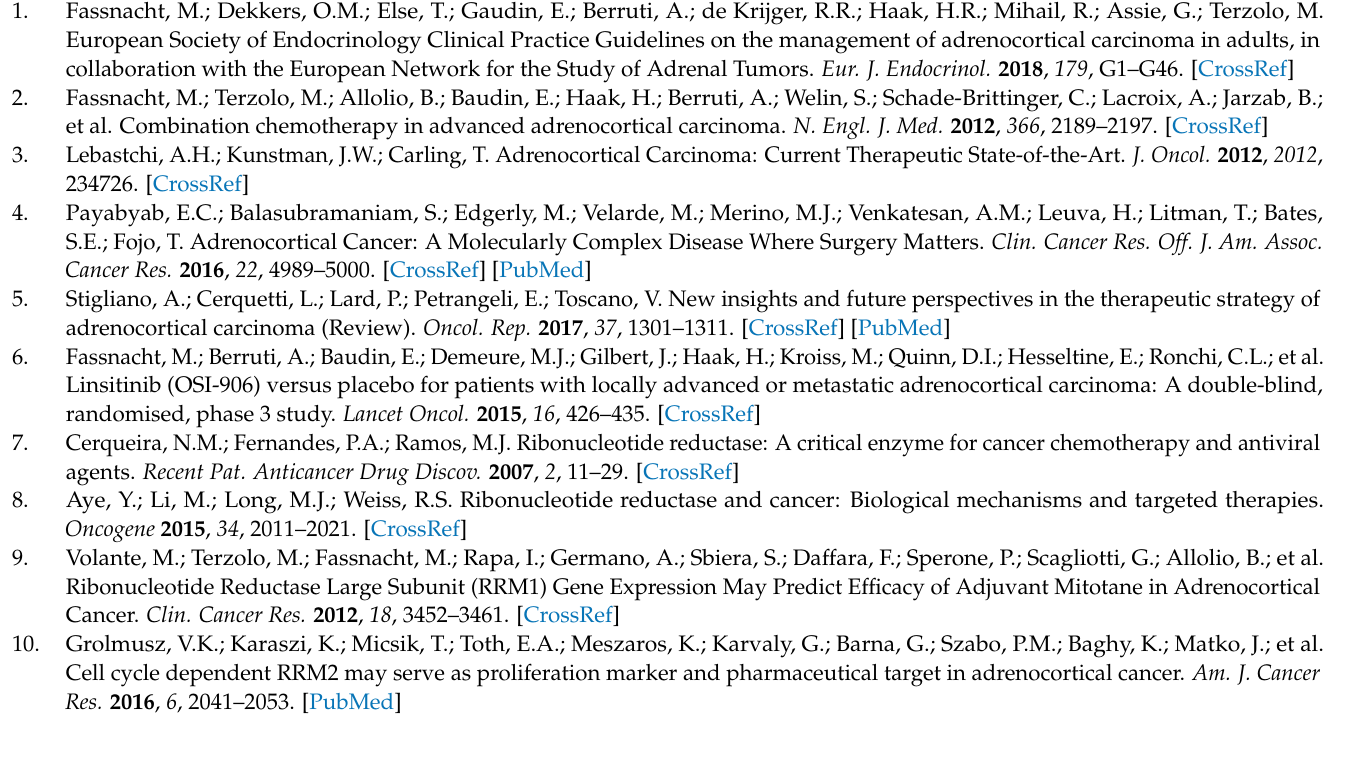
Figure 5H, Figure S4. Western Blots used for the graph generation in Figure